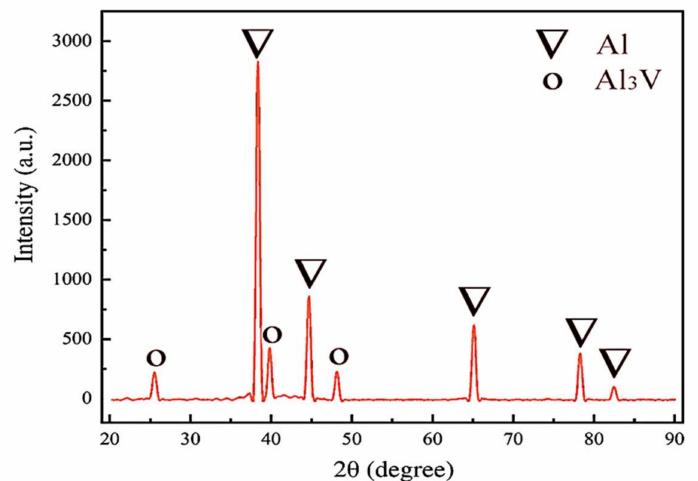
Figure 11. XRD data from fracture cross-section.